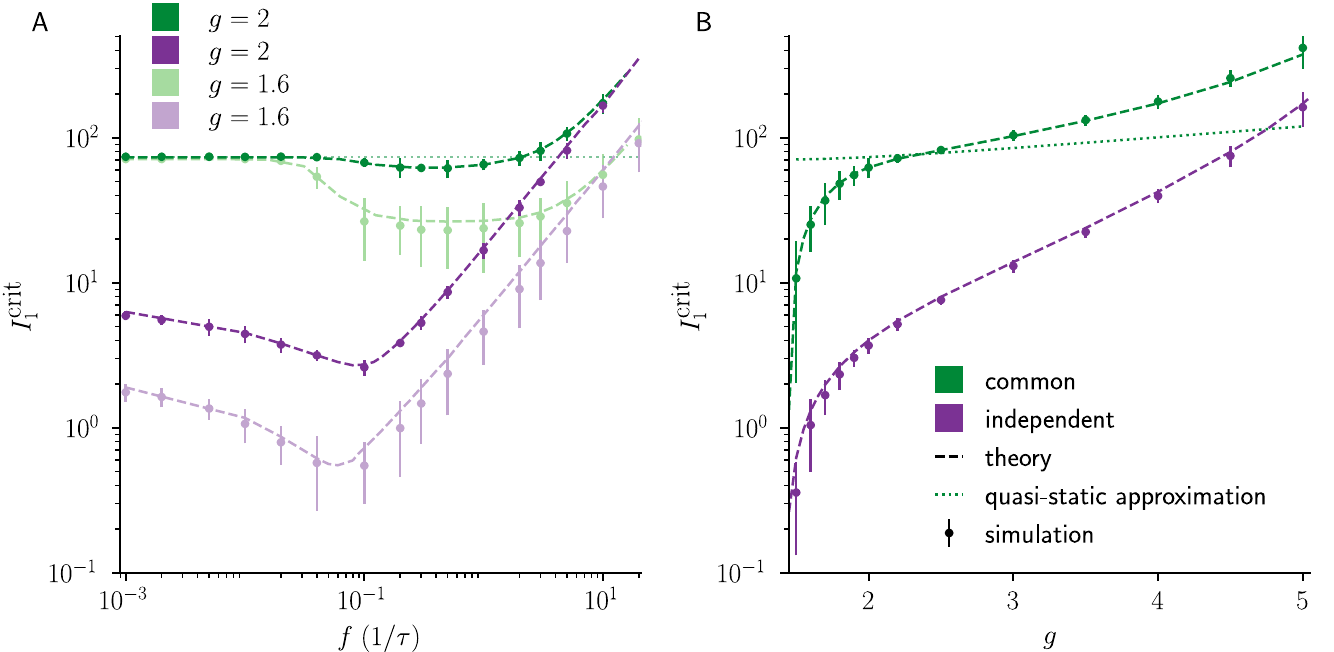
Fig 5. Dynamic mean-field theory captures frequency-dependent effects on the suppression of chaos. A) I crit as a function of input frequency f ( g = 1.6 light color, 1 has a minimum that is captured by the non-stationary DMFT (dashed green line) but not by the quasi-static approximation (dotted green line), g = 2 dark color). I crit 1 which does not depend on frequency f . At high f , the low-pass filter effect of the leak term attenuates the external input modulation for both cases, thus resulting in a linearly increasing I crit . B) Dependence of I crit on the gain parameter g for high input frequency ( f = 0.2/ τ ), showing a monotonic increase. The non-stationary DMFT 1 1 results are in good agreement with numerical simulations. For comparison, we include the result of the quasi-static approximation (dotted green line), which shows a more gradual dependence on g and applies only at low frequencies (see Fig 3). Error bars indicate ± 2 std. Model parameters: N = 5000, g = 2, f = 0.2/ τ , I 0 = J 0 = 1.